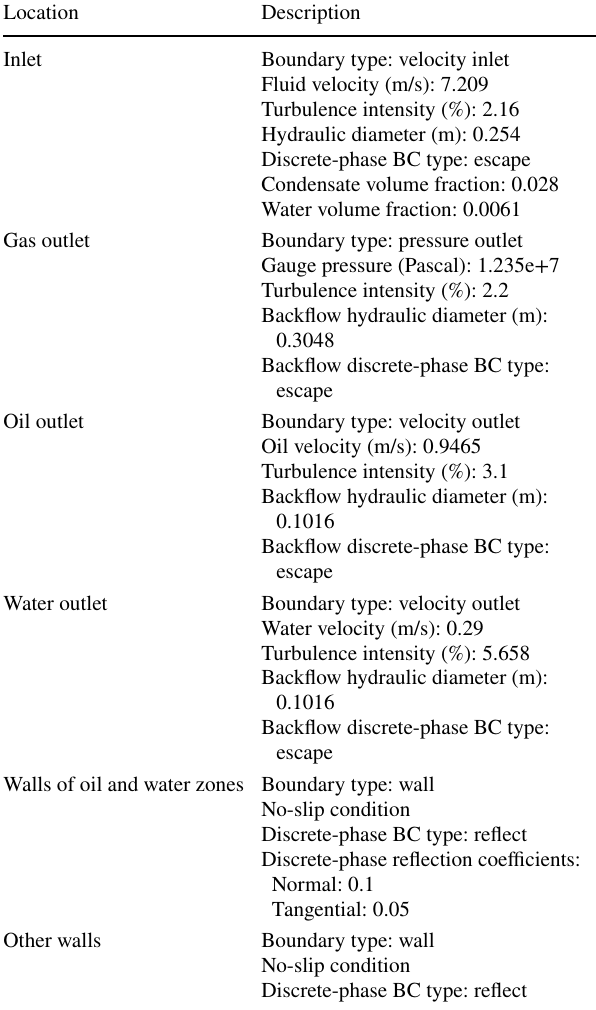
Table 4 Implemented simulation boundary conditions Location